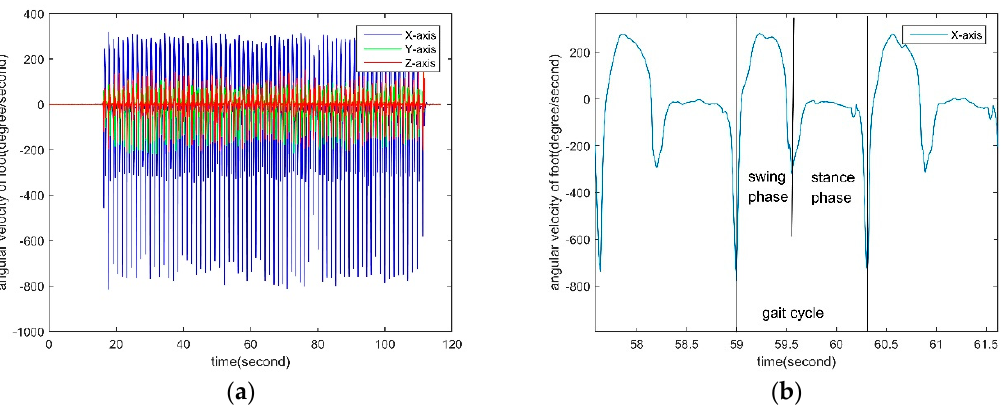
Figure 4. Angular velocity data of the foot. ( a ) Three-axis angular velocity data of the foot; ( b ) Partially enlarged for X-axis angular velocity data of the foot.